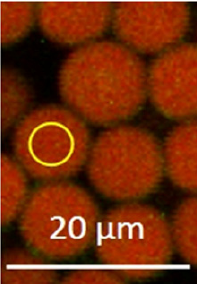
Figure 1. Confocal laser scanning microscope (CLSM) range of interest (ROI) circle inside of fluorescent melamine formaldehyde (MF) particles. Amplification 140×.